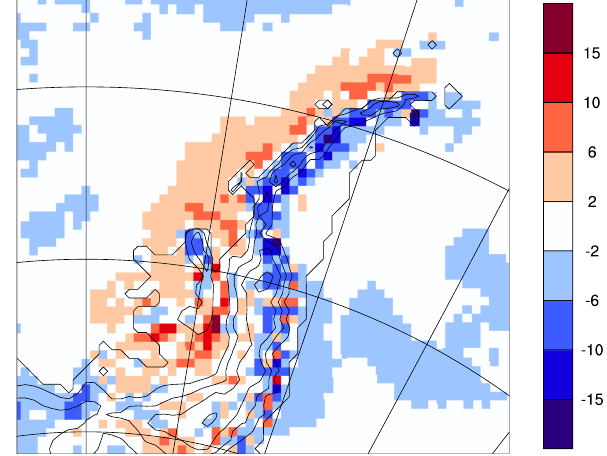
Figure 5. Relative difference (%) in precipitation between the UAR simulation and the reference RACMO2 simulation over the Antarc- tic